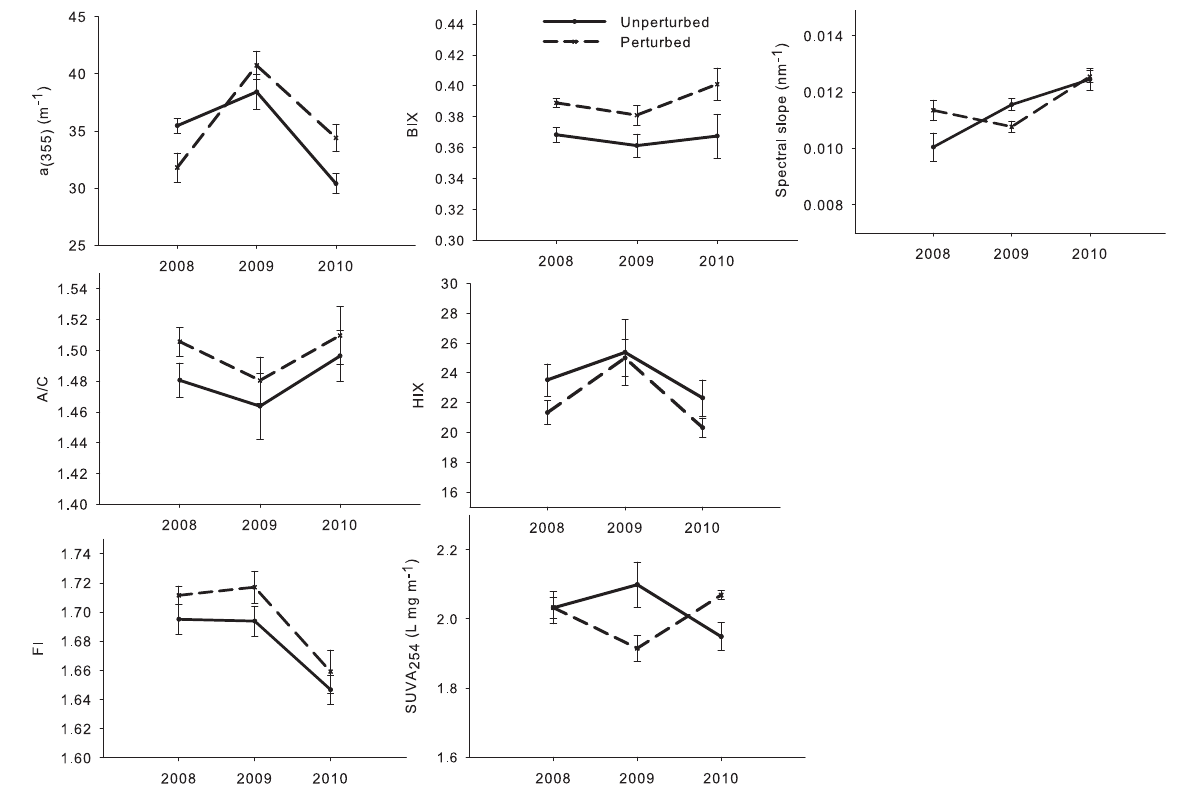
Figure 3. Comparison between treatments (unperturbed, perturbed) and years (2008, 2009, 2010) of a cDOM ( λ = 355), A / C, FI, BIX, HIX, SUVA 254 and spectral slope. Vertical bars represent standard